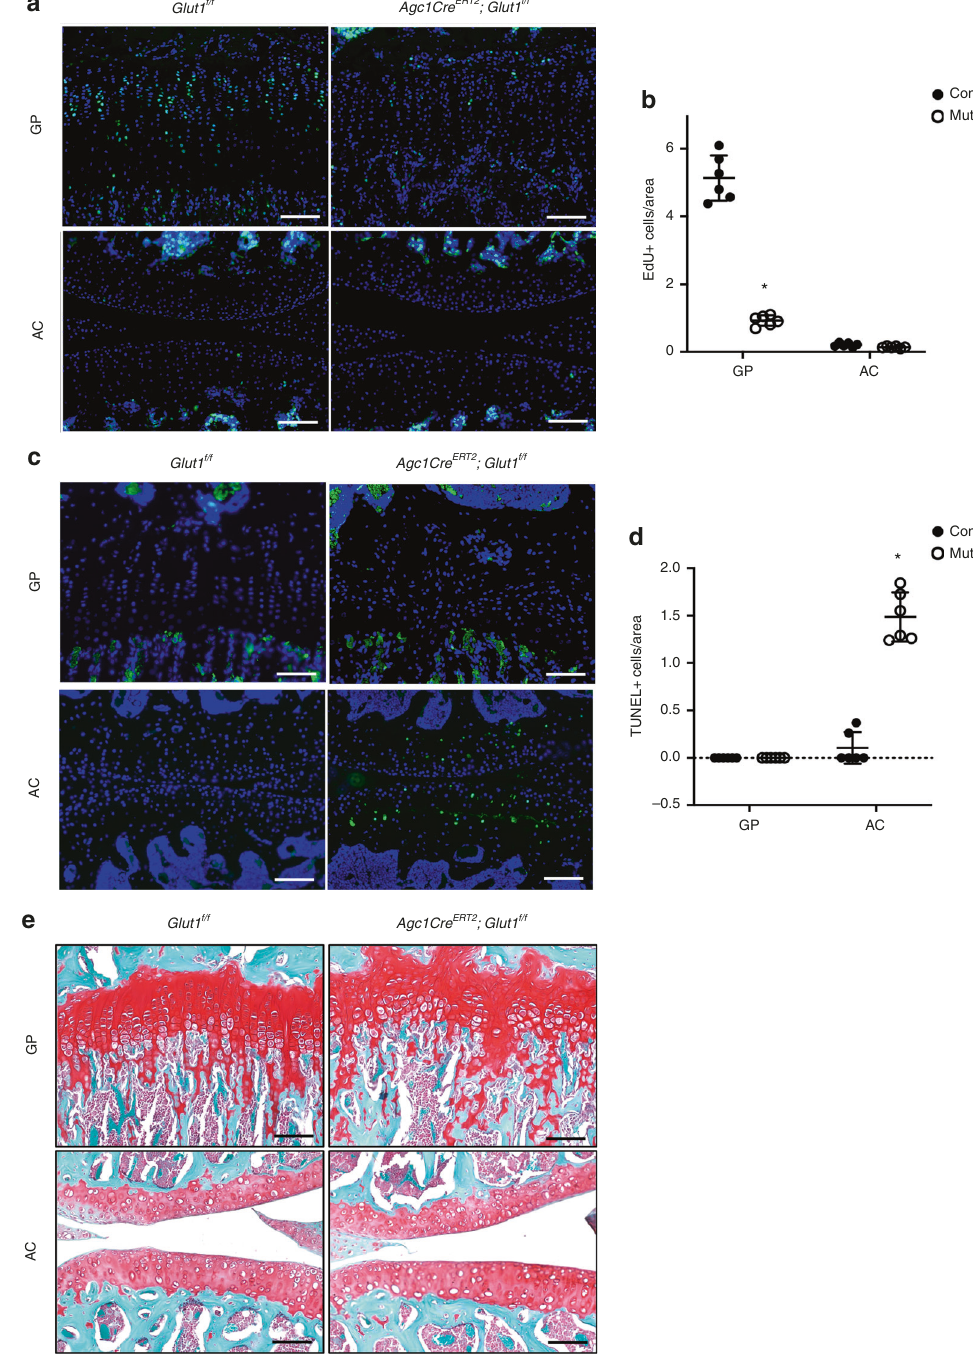
Fig. 5 Glut1 is required for GP chondrocyte proliferation and AC chondrocyte survival. a – b EdU labeling ( a ) and quanti fi cation of EdU-positive cell counts ( b ) in the GPs and AC of control and Glut1 LOF mice at 1 week following tamoxifen induction. The data are the mean ± SD. N = 6. Scale bar, 100 μ m. * P < 0.05 compared to the controls. c – d TUNEL staining and quanti fi cation of TUNEL-positive cell counts in the GPs and AC of control and Glut1 LOF mice 1 month following tamoxifen induction. The data are the mean ± SD. Scale bar, 100 μ m. N = 6. * P < 0.05 compared to the controls. e – f Safranin O/Fast Green staining of tibia and knee sections of control and Glut1 LOF 1 month following tamoxifen induction. N = 6. Scale bar, 100 μ plausible that the MMP13 levels in Glut1 LOF cartilage are used in mice to inhibit P4h-mediated collagen processing and increased in an attempt to degrade the modi fi ed cartilage matrix deposition. 34 Histological examination revealed that in vivo (Figs. 3c, 4d). Finally, to validate the importance of P4h for blockade of P4h with DHB remarkably normalized the increased cartilage remnants in Glut1 LOF mice, 1-month-old control and amount of cartilage remnants seen in the metaphyseal region in Glut1 LOF mice were treated with DHB every other day for Glut1 LOF mice (Fig. 7e). In contrast, this P4h inhibitor had no 2 months. DHB is a selective P4h inhibitor 33 and has been safely effect on the shortening of GPs or on the decreased cellularity in